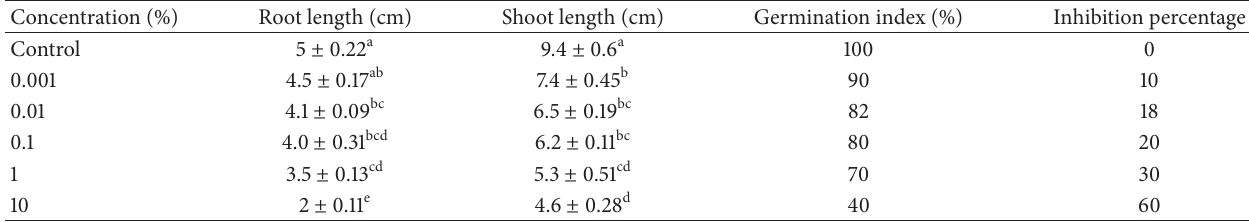
Table 1: Root, shoot length, and germination index of wheat seeds in the presence of PSL